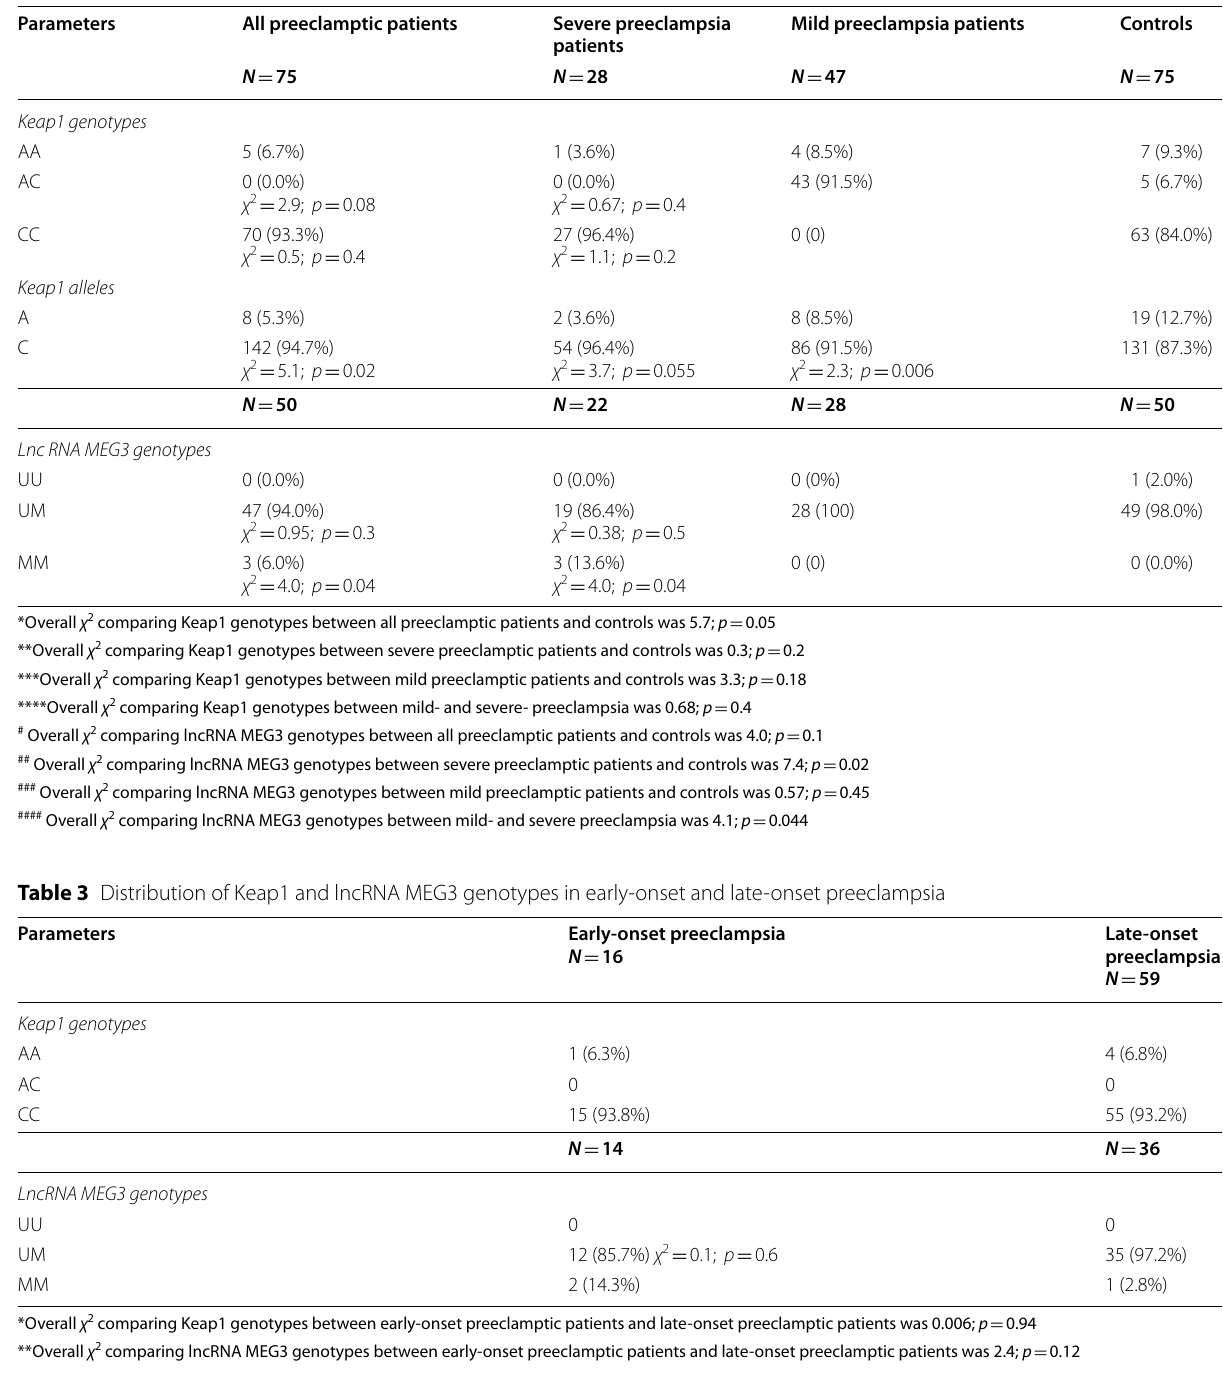
Table 2 Distribution of Keap1 and Lnc RNA MEG3 genotypes in patients with preeclampsia, severe- and mild preeclampsia patients and controls